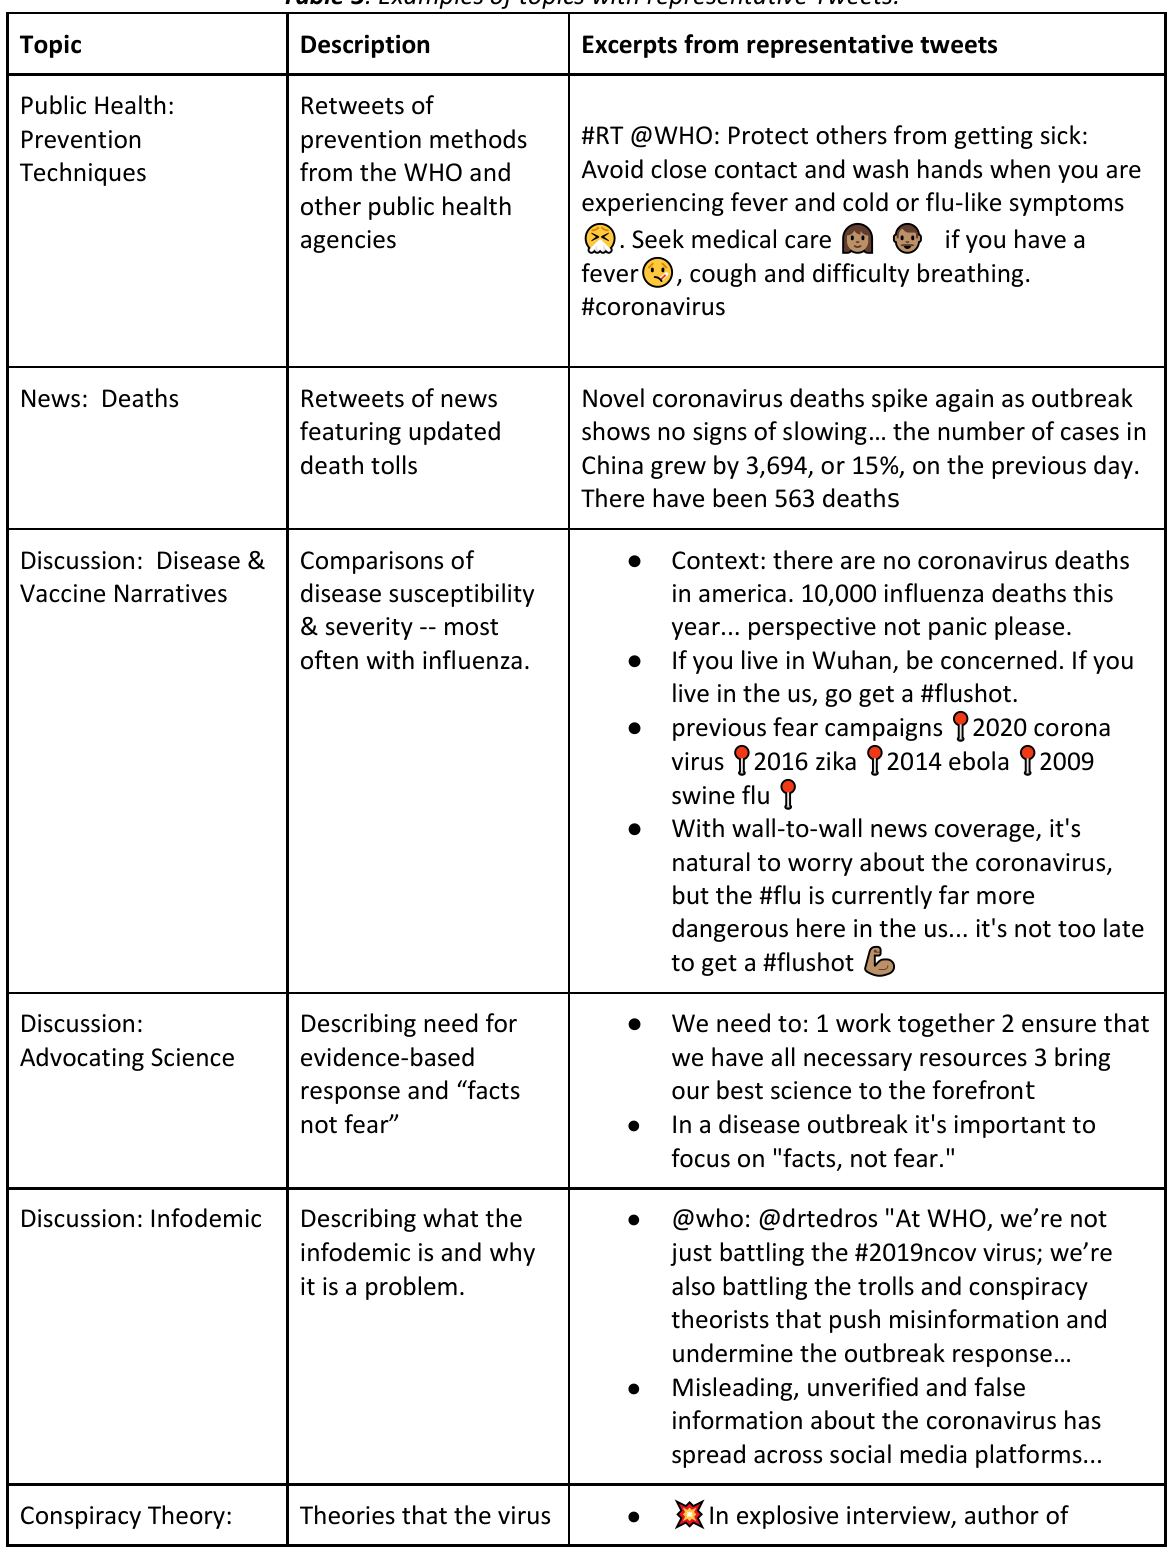
Table 3 . Examples of topics with representative